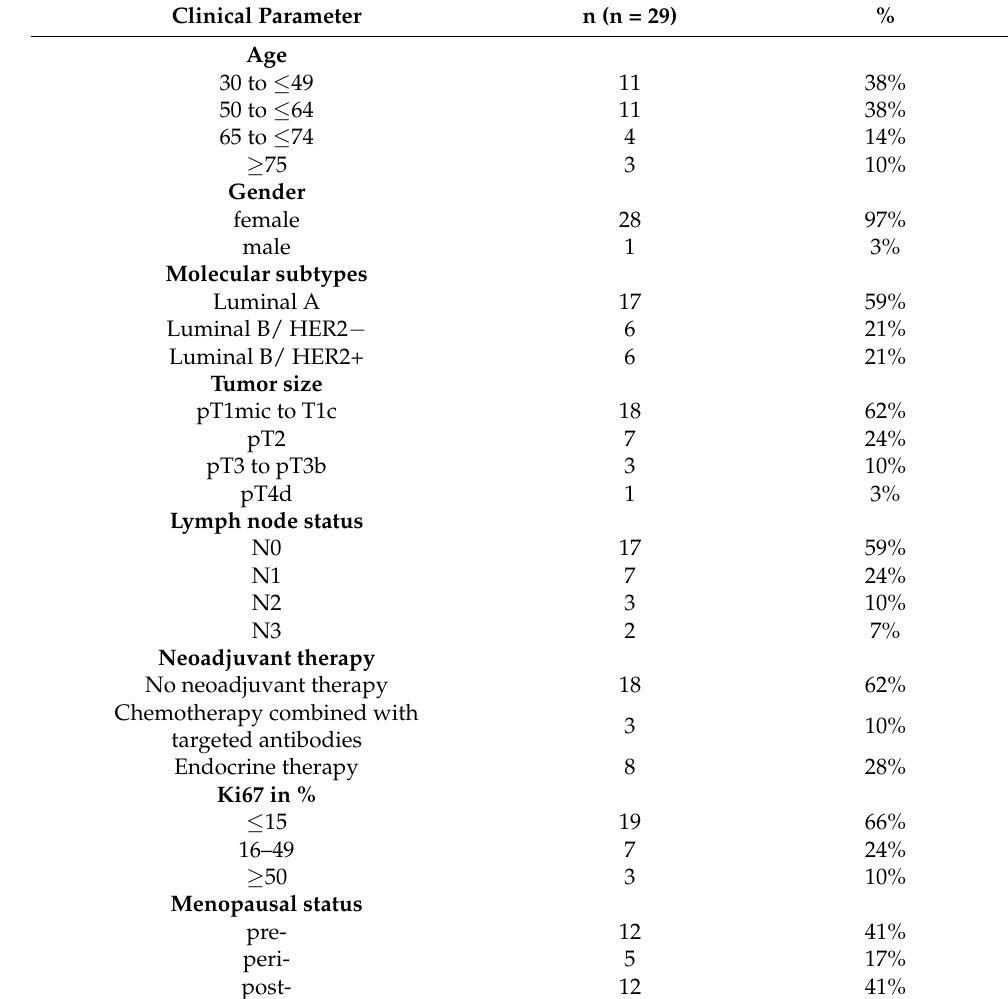
Table 1. Patient characteristics and clinical parameters of primary tumor